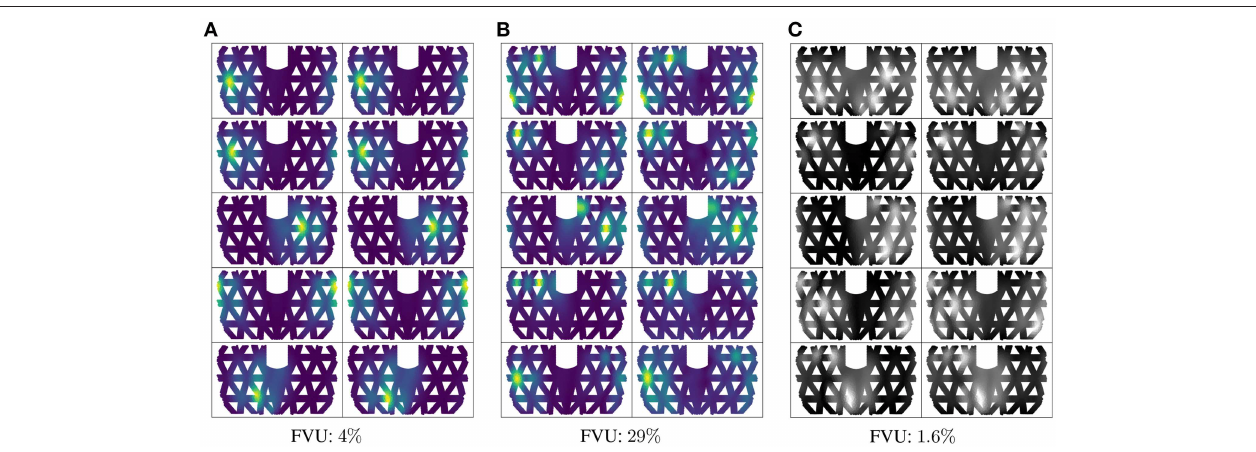
FIGURE 6 | Deformation prediction results: (A,B) are deformation patterns of single- and double-contact based on the data collected from the real system. Left columns show ground truth (simulation: S to D) and right columns the prediction for random samples (real: R to S to D). (C) shows predicted deformation patterns of triple contact based on simulated sensor values (S to